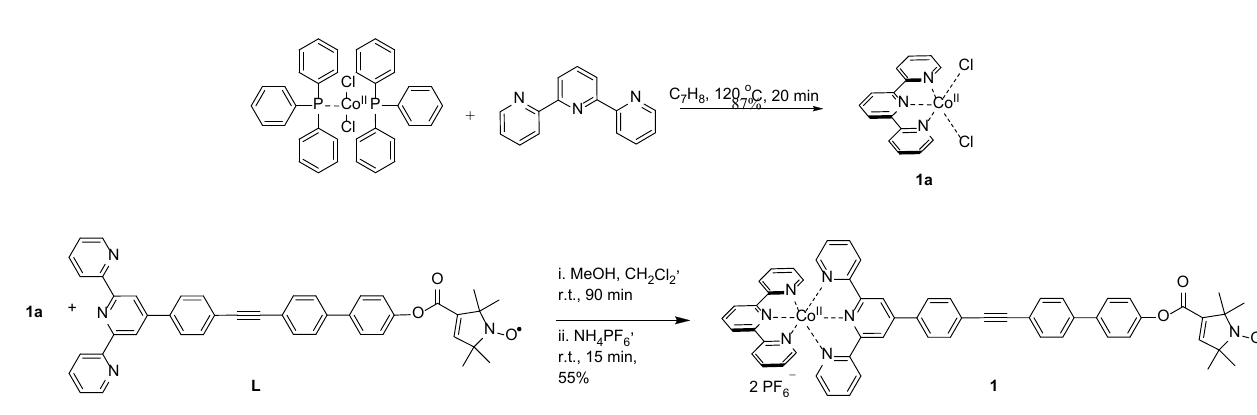
Scheme 1. Synthetic procedure of precursor 1a and of target complex 1 .